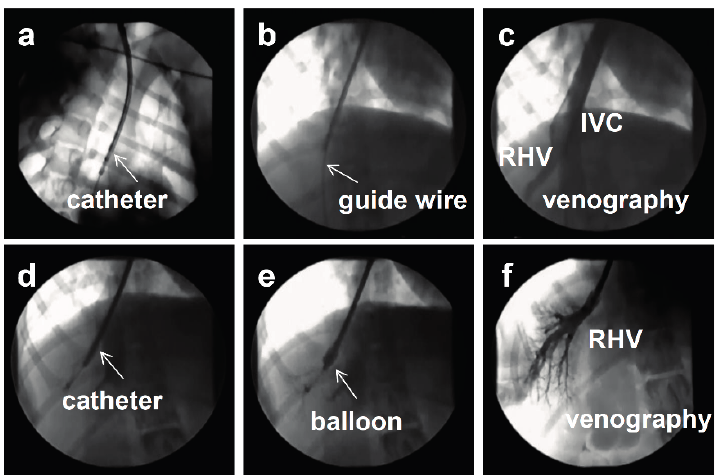
Figure 3. Image-guided procedure for hydrodynamics-based delivery. ( a ) A short sheath is inserted into the jugular vein, followed by an insertion of a balloon catheter. ( b ) Site- specific insertion of guide-wire into the target lobular hepatic vein. ( c , d ) Confirmation of target hepatic vein using a small amount of phase contrast. RHV, right hepatic vein, IVC, inferior vena cava. ( e ) Inflation of the balloon on the tip of the catheter to block the backflow. ( f ) Verification of the obstruction of blood flow by injecting a small volume